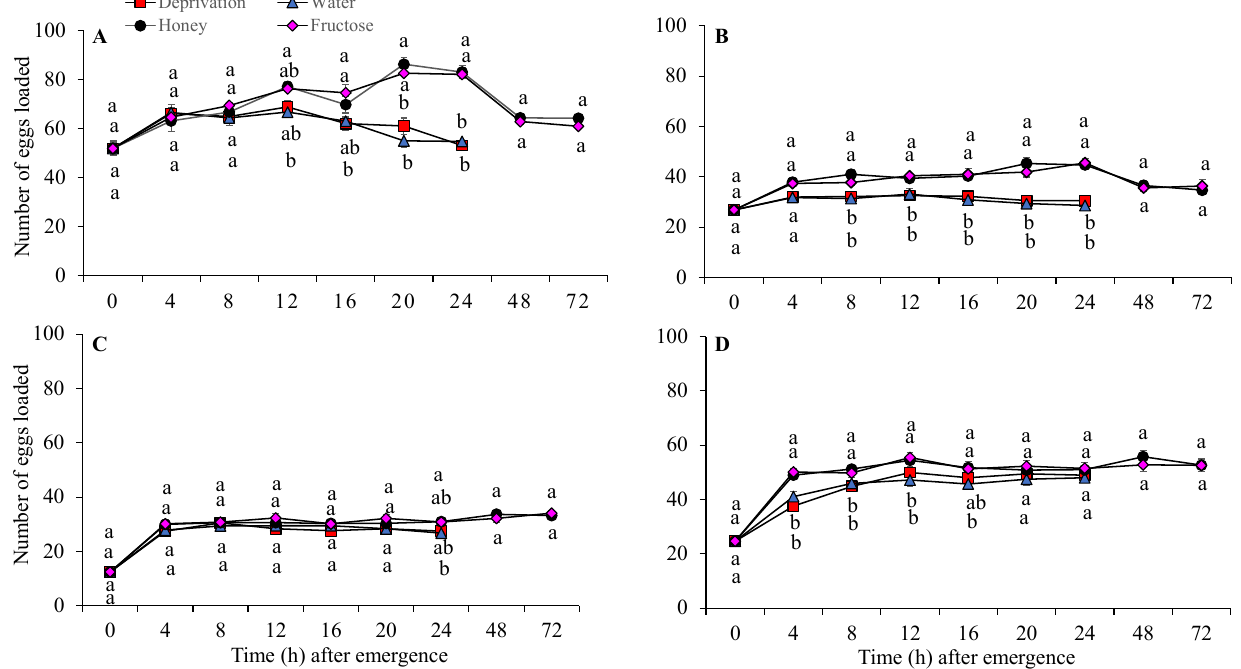
Figure 1. Impact of carbohydrate-rich diet on the egg load of four Trichogramma species with time. T. dendrolimi ( A ), T. chilonis ( B ), T. leucaniae ( C ), and T. ostriniae ( D ). The number of egg loads was given as mean ± SE. Different lowercase letters in each figure indicate significant differences among different treatments (Tukey’s HSD test, p < 0.05).